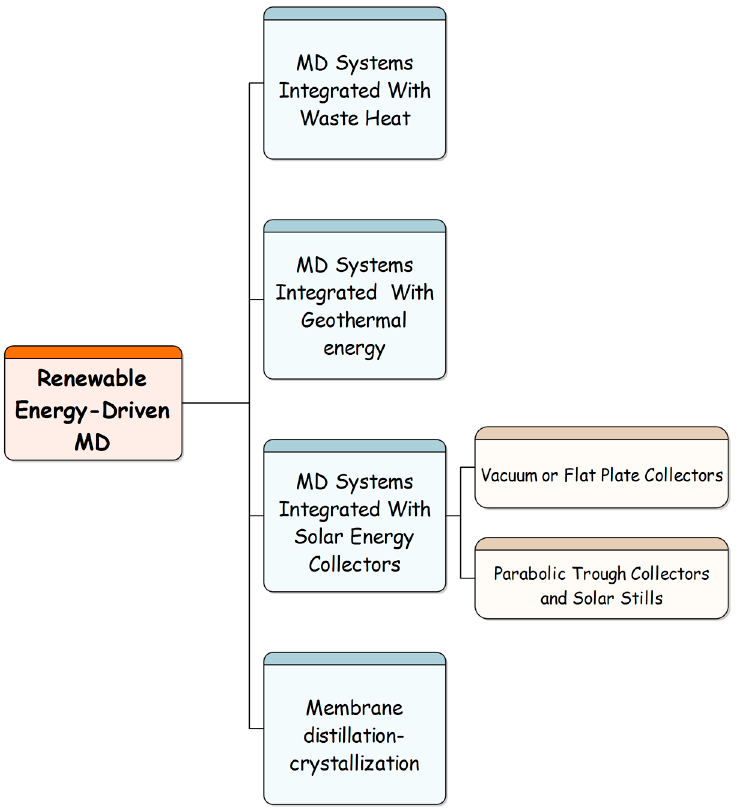
Figure 12. Schematic diagram of various renewable energy ‐ driven MD systems.